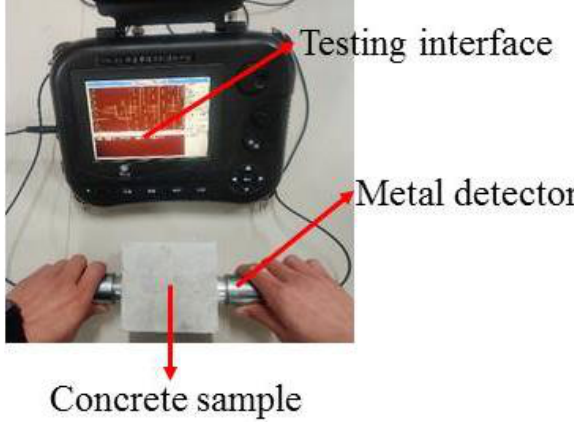
Figure 3. NA-M4 nonmetal ultrasonic detector.